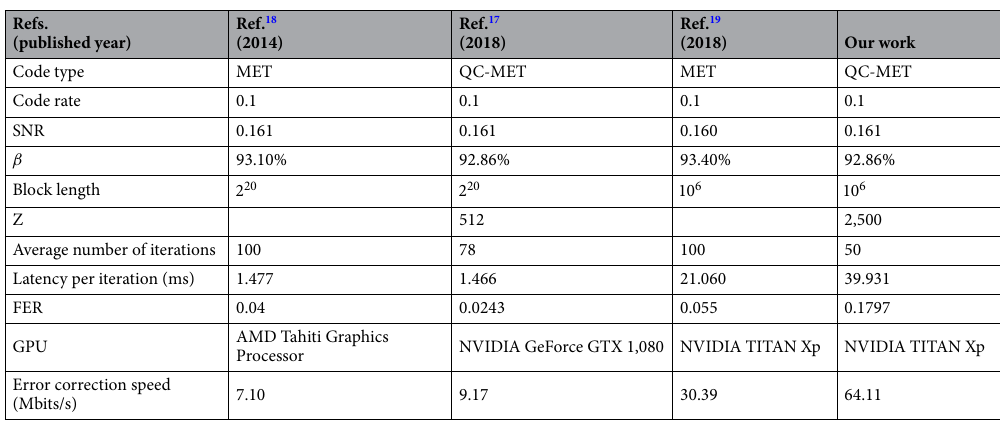
Table 4. Performance comparison with prior works using different types of